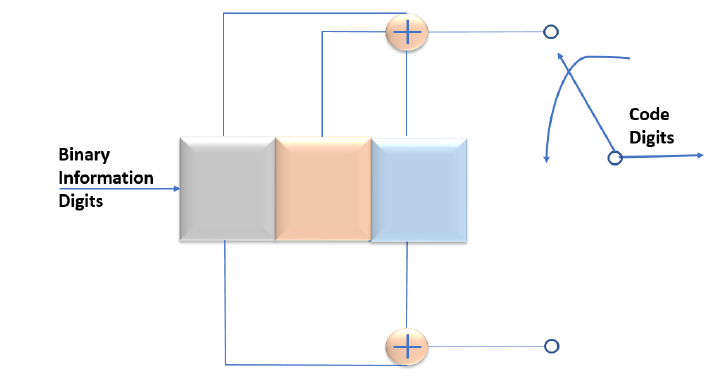
Figure 4. Illustration of a non-systematic convolutional encoder at half rate.